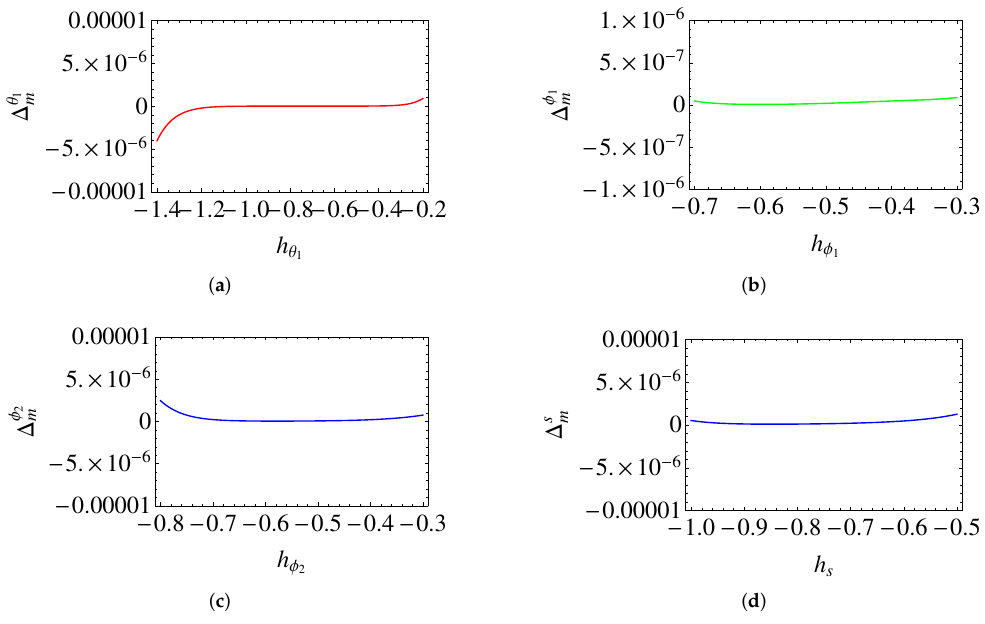
Figure 3. h -curve for the residual error ( a ) ∆ θ 1 m , ( b ) ∆ φ 1 m , ( c ) ∆ φ 2 m and ( d ) ∆ s m .